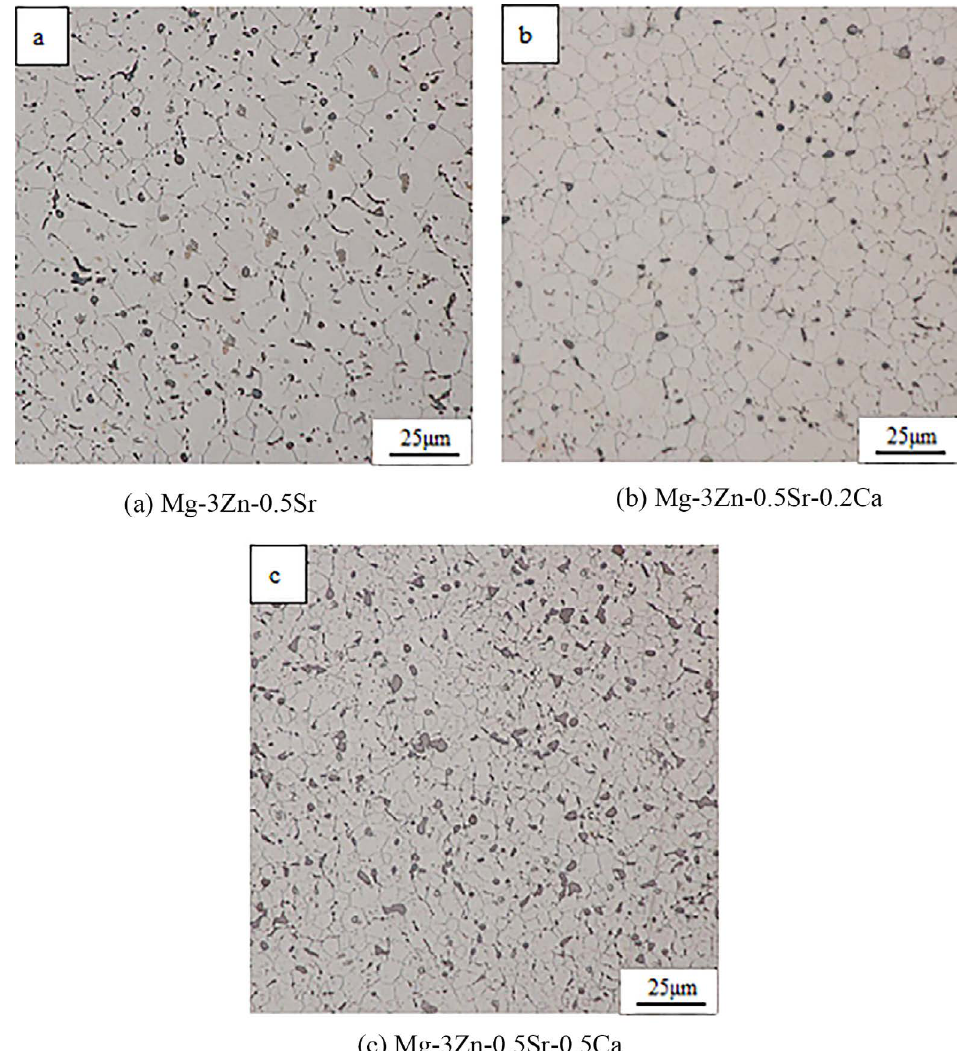
Figure 2. The optical micrographs of Mg-3Zn-0.5Sr-xCa alloys perpendicular to extruded direction, (a) Mg-3Zn-0.5Sr; (b) Mg-3Zn-0.5Sr-0.2Ca; (c) Mg-3Zn-0.5Sr-0.5Ca